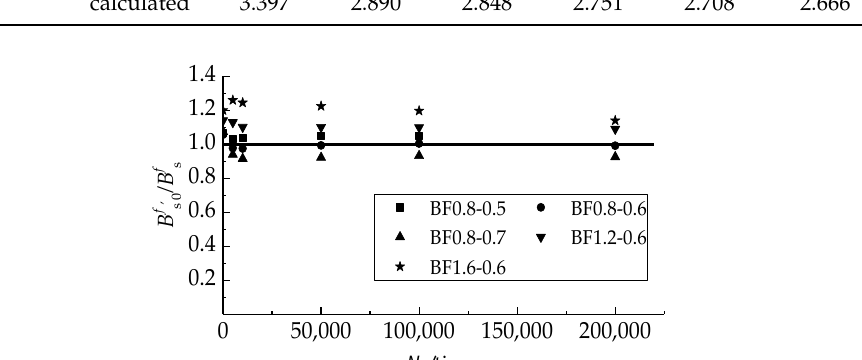
Figure 9. Comparison of tested to computed flexural stiffness at different cyclic numbers of fatigue load.